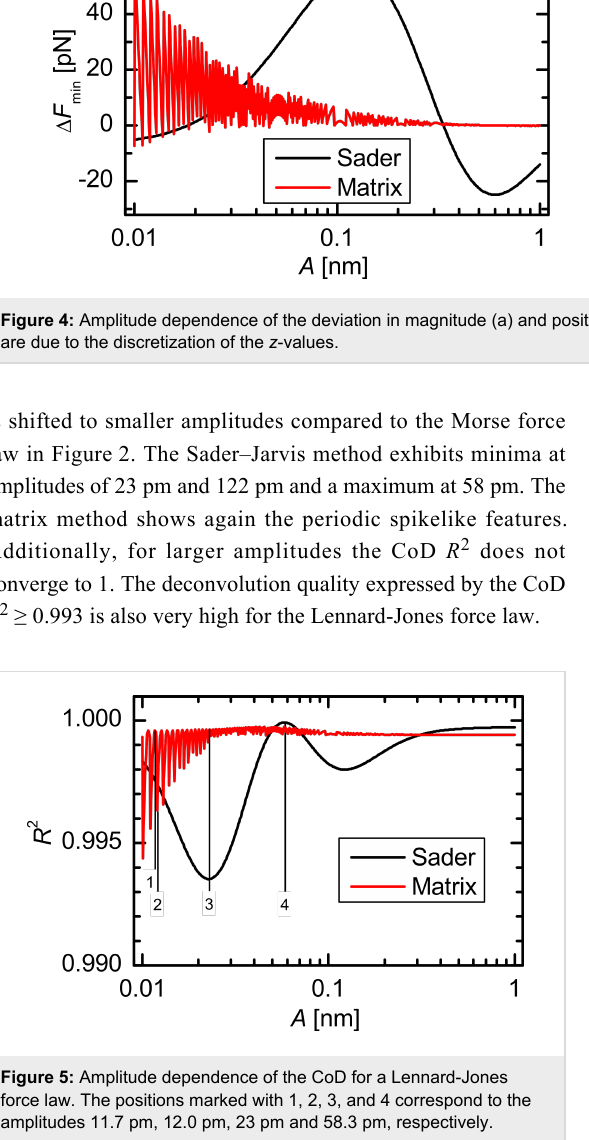
Figure 5: Amplitude dependence of the CoD for a Lennard-Jones force law. The positions marked with 1, 2, 3, and 4 correspond to the amplitudes 11.7 pm, 12.0 pm, 23 pm and 58.3 pm,